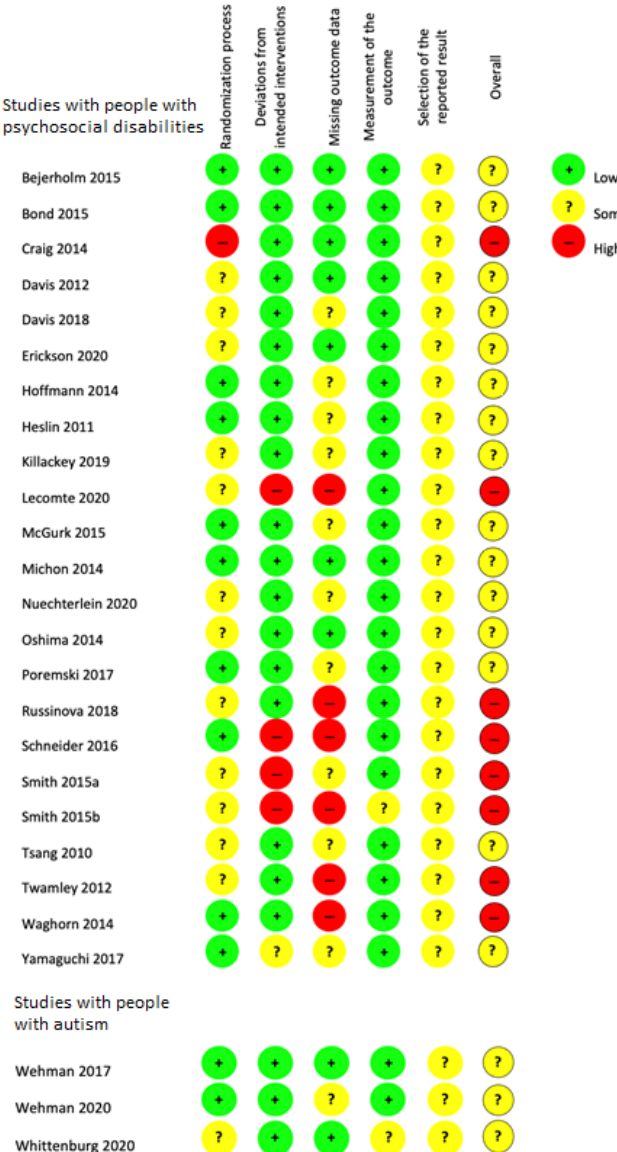
Figure 2. Risk of bias in included studies.